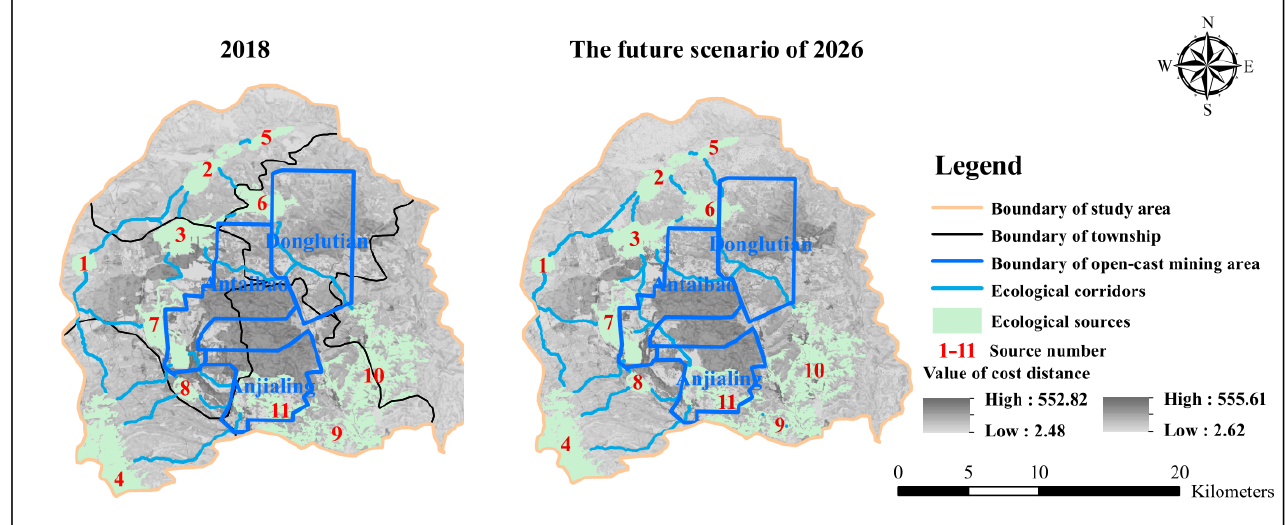
Figure 8. Spatial patterns of ecological network.